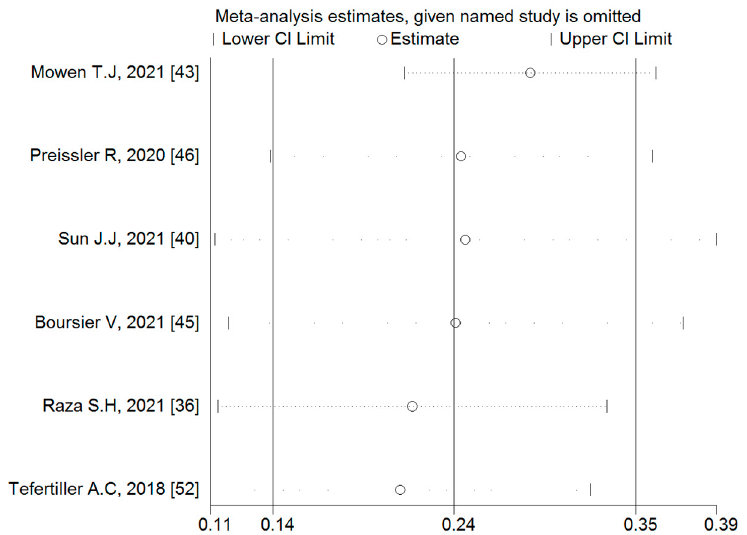
Figure 8. The sensitivity analysis plot assessing the small study effects in the estimated pooled Fisher’s z-score in the association between binge-watching and anxiety.